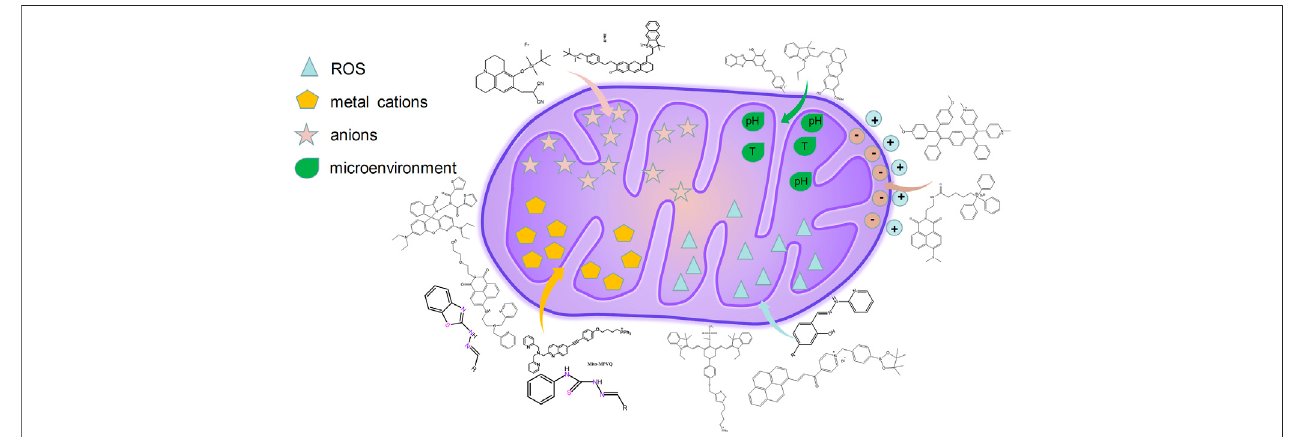
FIGURE 1 | The design strategies of fl uorescence probes targeting